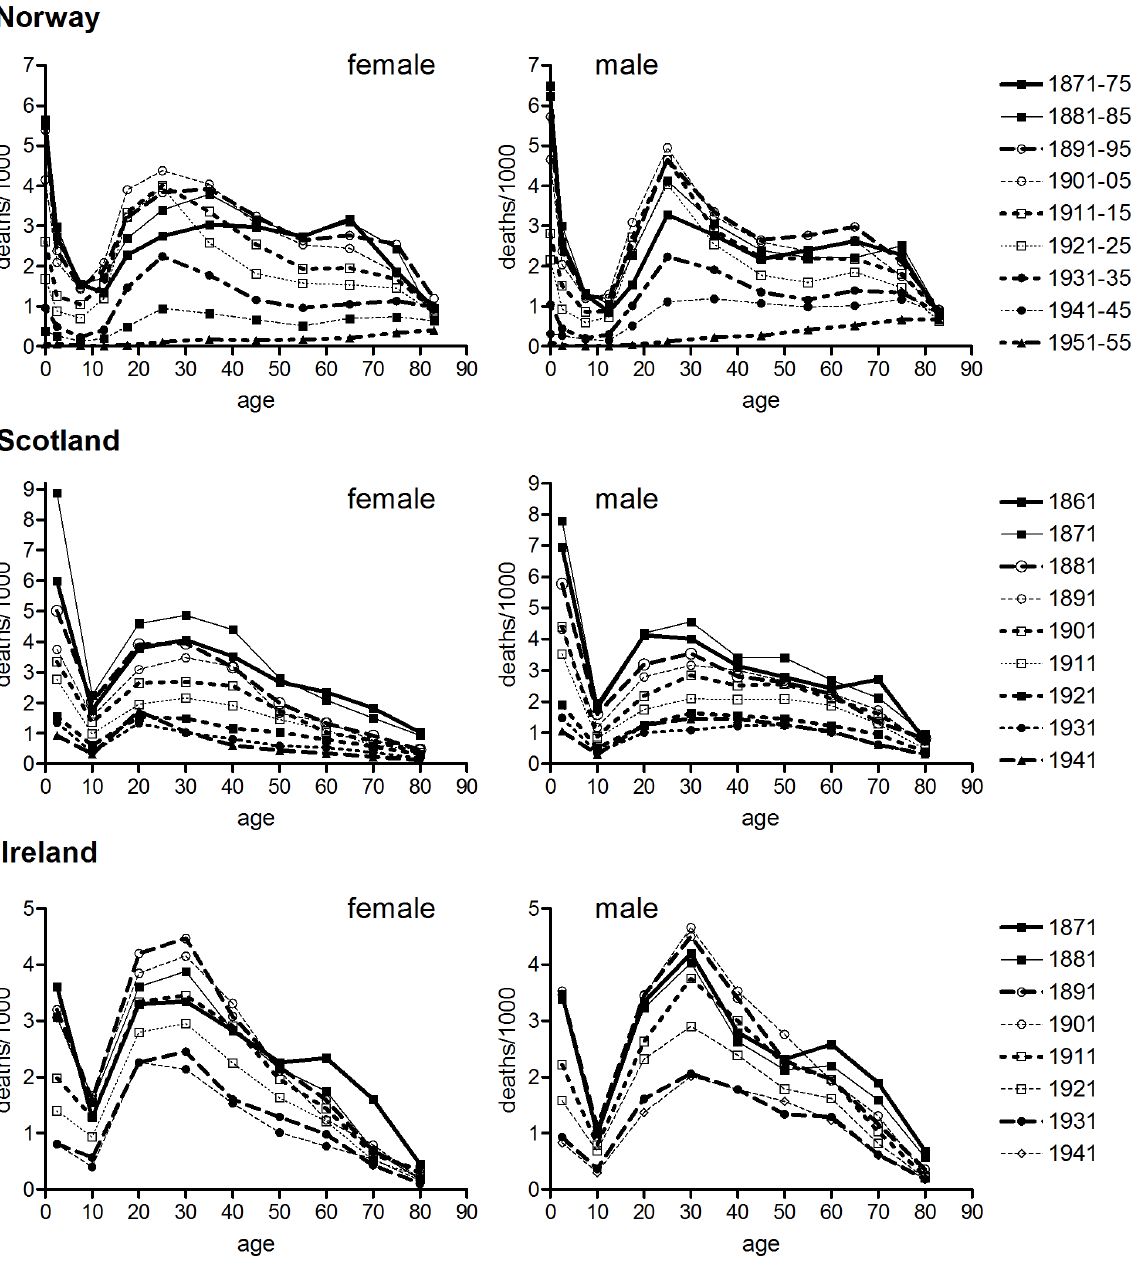
Figure 2. Age-specific tuberculosis mortality by period of death. Data refer to five yearly rates of respiratory tuberculosis ages 0–14, all tuberculosis ages 15 + (Norway), or single years of data at decadal intervals, all tuberculosis (Scotland,